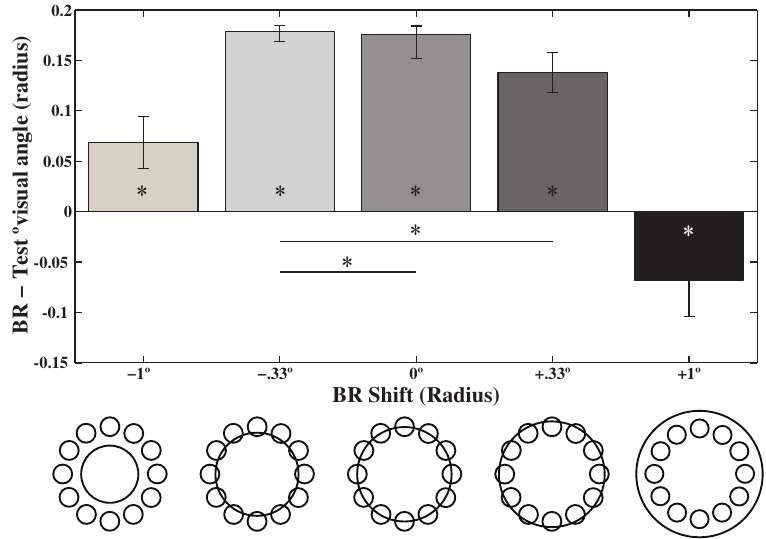
Figure 5. Stimuli and results of experiment 2. The radius of the binding rings from left to right: 2°, 2.67°, 3°, 3.33° and 4°; circular array radius was consistently 3°. The graph illustrates the PSEs for each stimulus type: lines and asterisks below the bars indicate significant (p < 0.05) differences, based on post-hoc paired t-tests, between the three overlapping binding ring conditions. Superimposed asterisks indicate significant changes in perceived size induced by the presence of the binding ring compared to an array without a binding ring (observed for all five conditions). A positive shift on the ordinate axis indicates that the array must increase in size to be perceived as having the same radius as the reference and vice versa. Error bars indicate standard error of the mean.